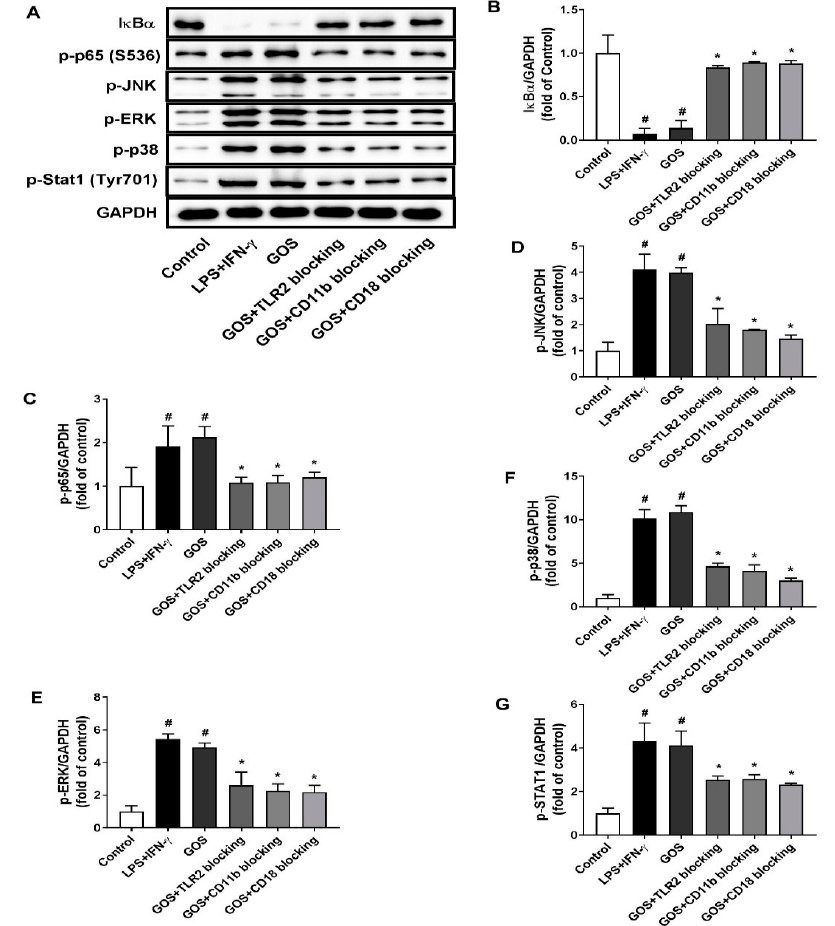
Figure 7. Effects of receptor blocking of TLR2 and CR3 (CD11b/CD18) on GOS activated mitogen-activated protein kinases (MAPKs) and nuclear factor-kappa B (NF- κ B) signaling pathways. Western blotting of protein expression ( A ) and accordingly the densitometry quantification of the expressed protein bands I κ B α ( B ), p-p65 ( C ), p-JNK ( D ), p-ERK ( E ), p-p38 ( F ), and p-Stat1 ( G ) in BMDMs pretreated with anti-CR3 (CD11b/CD18) and anti-TLR2 blocking antibodies and incubated with GOS (100 µg/mL). Results were expressed as the mean ± SD of at least three replicates. # —Indicated significant difference versus the control group at p < 0.05. * —Indicated significant difference versus the GOS group at p < 0.05.